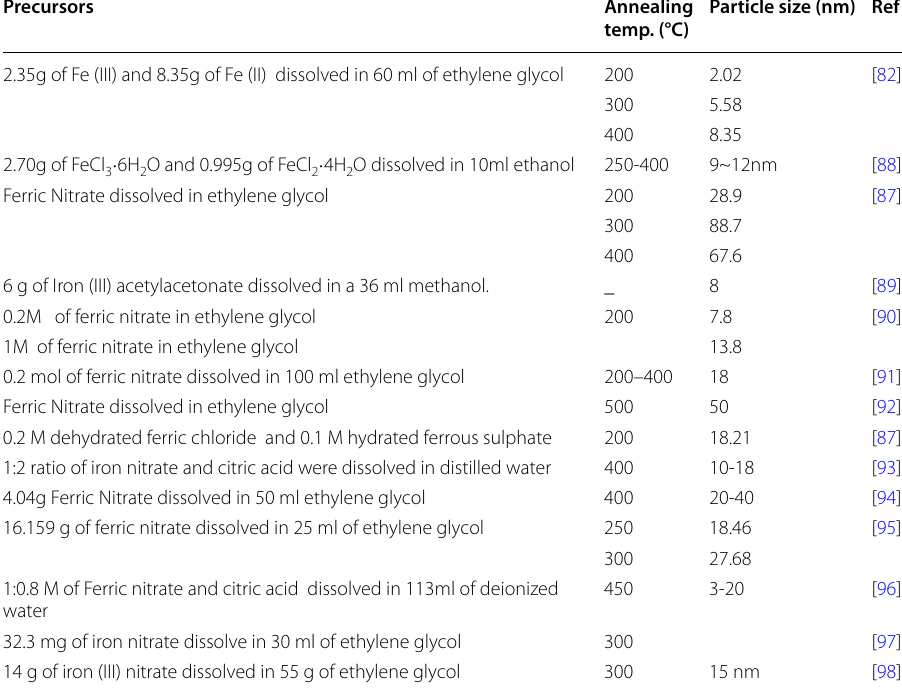
Table 3 Summary of magnetite nanoparticles synthesis by Sol-Gel method Precursors